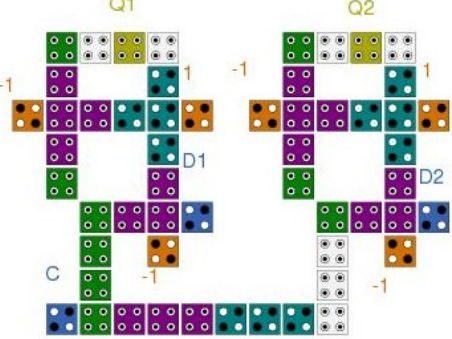
Figure 11. QCA implementation of 2-bit PIPO shift register.